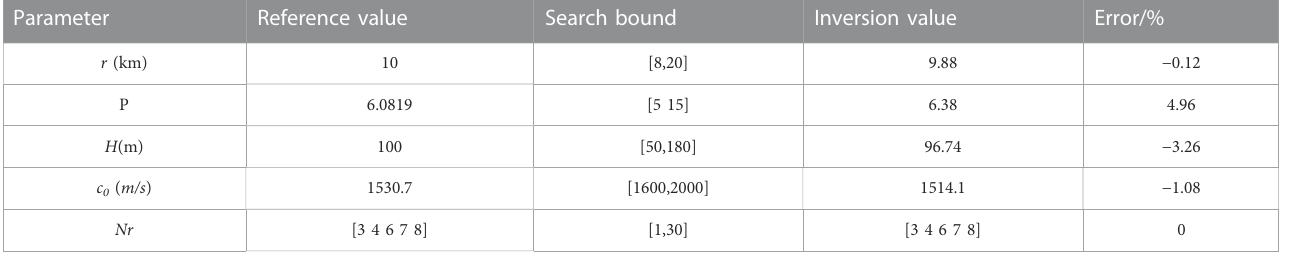
TABLE 1 Inversion parameter list.